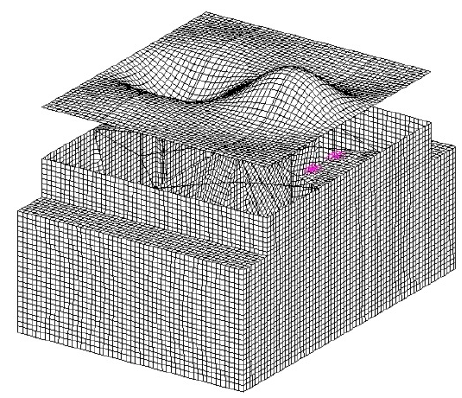
Figure 10. The local modal shape of the satellite.